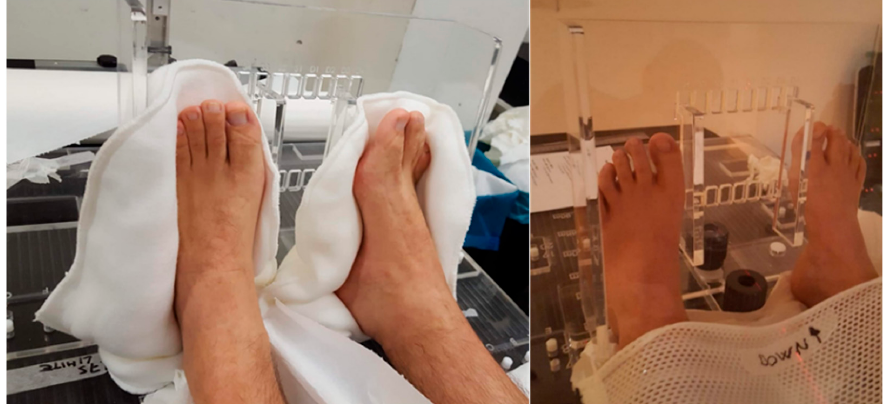
Figure 2. Feet positioning with ( left ) or without ( right ) a personal cushion.